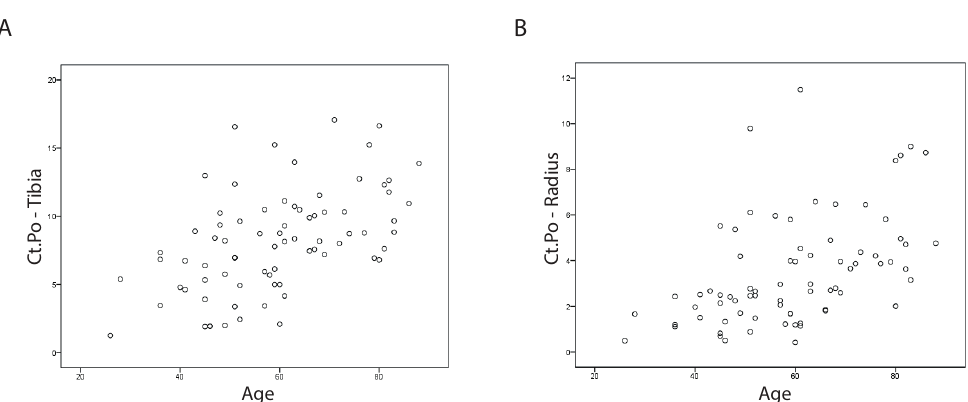
Fig 2. Association of Ct.Po and age in hemodialysis patients in the tibia (A) and radius